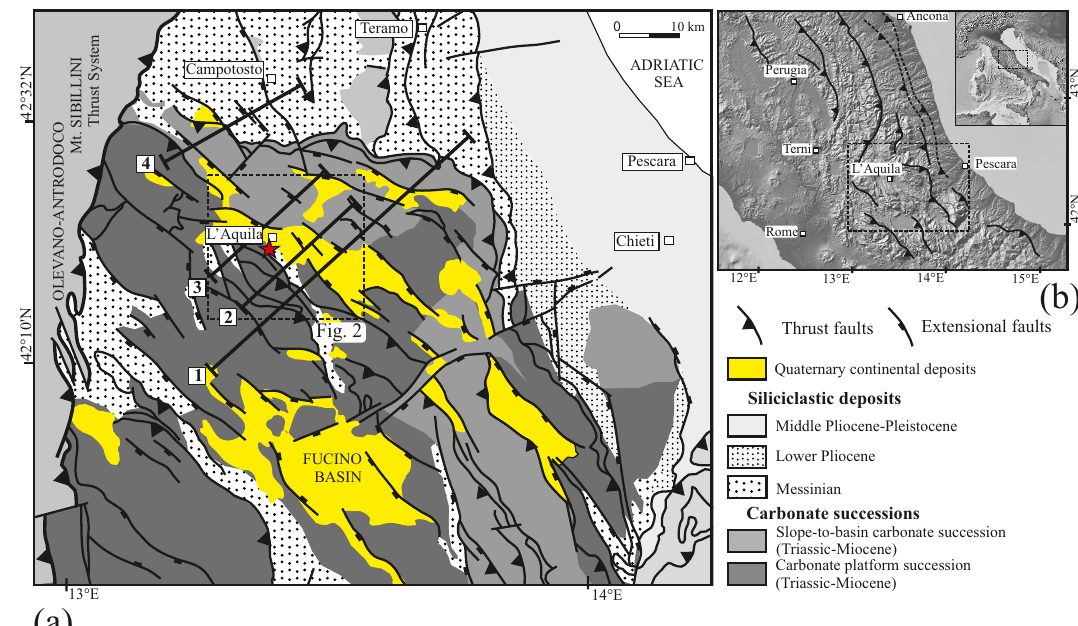
Figure 1. (a) Tectonic map of the Abruzzi region (modified from Vezzani et al., 2009). The present morphology of the axial portion of the Apennines is still dominated by the folding and thrusting through which the chain was built up over a long time interval between the upper Miocene and the middle Pleistocene. Subsequent extension and intervening sedimentation in intermontane basins has so far only slightly modified the compressional architecture of the Apennines. A dashed box indicates the exact location of the study area. 1, 2, 3, and 4 indicate cross sections. (b) Digital elevation model of the central Apennines, showing the trend of the main thrust fronts. A number of secondary fronts are also clearly delineated by the